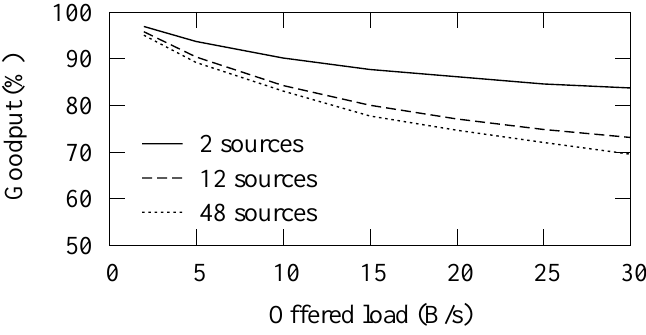
Figure 10. Goodput with different number of sources in